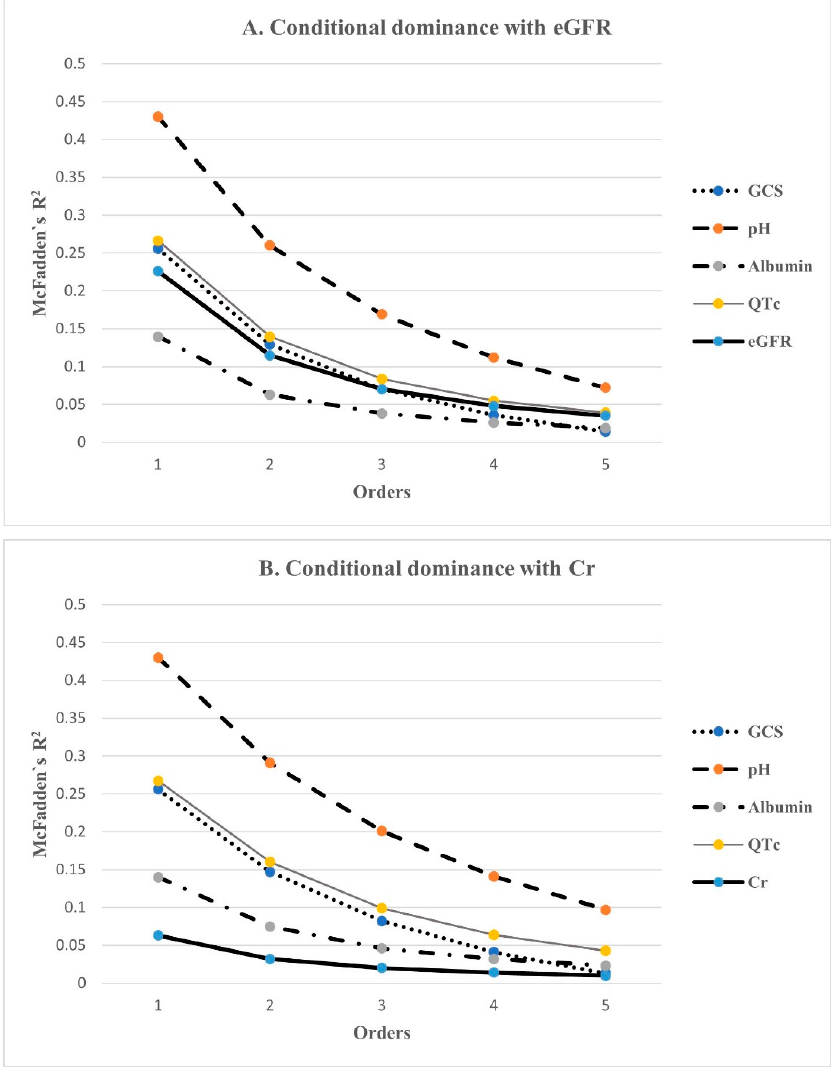
Figure 2. The conditional dominance of independent factors for predicting in-hospital mortality. Conditional dominance statistics of each variable were derived from averaging the 5 within-order subsets (1–5) of their R 2 s. The values tended to decrease as the level elevated. Among them, pH had the highest value in both analyses, while albumin had the lowest value in ( A ), and Cr was the lowest in ( B ). QTc, eGFR, and GCS had almost the same values. GCS: Glasgow Coma Scale; QTc: corrected QT interval; eGFR: estimated glomerular filtration rate; Cr: creatinine.